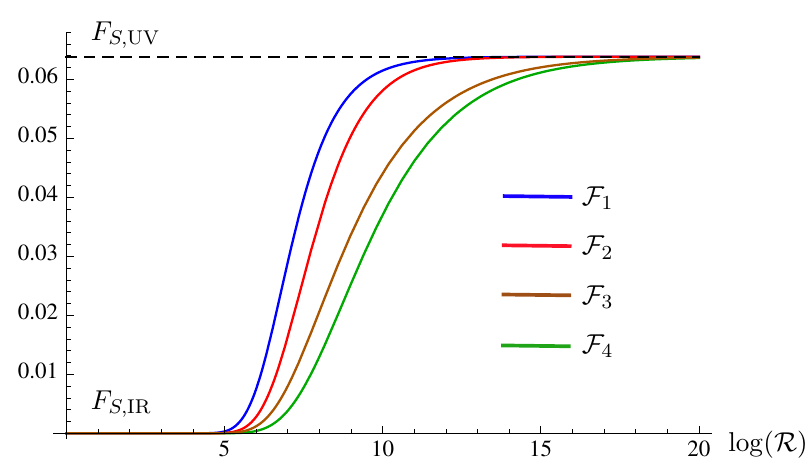
Figure 12. F 1 ; 2 ; 3 ; 4 given in (6.37){(6.40) vs. log( R ) for a theory of a free massive scalar on S 3 . The black dashed line indicates the value of F S; UV given in